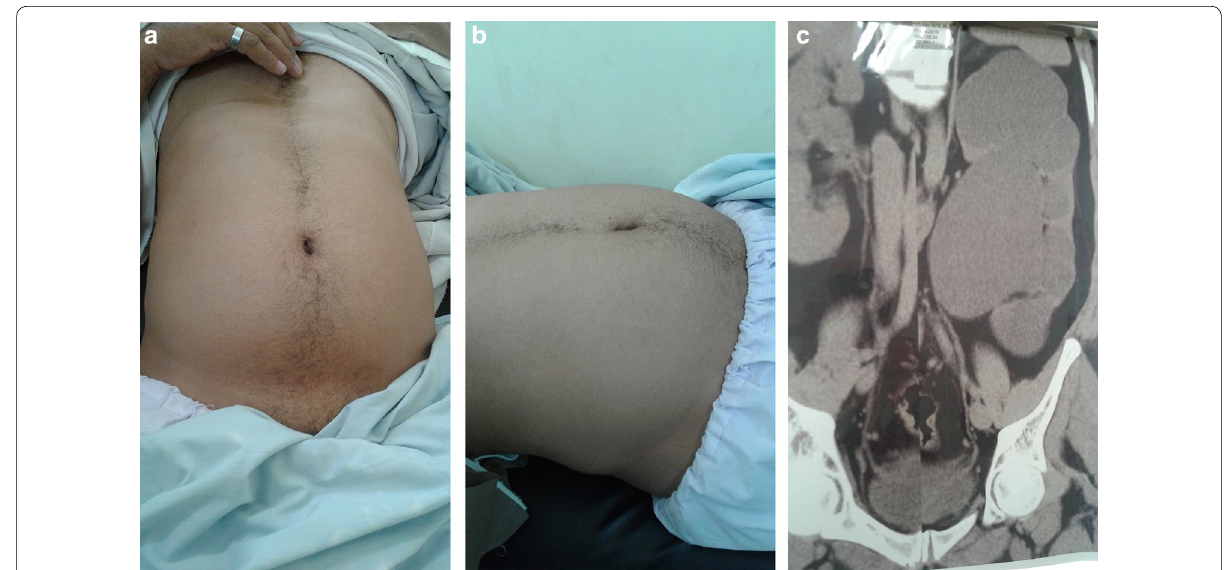
Fig. 2 A 45‑year‑old male patient presented with diffuse abdominal pain and distension due to left giant hydronephrosis. Clinically visible left hydronephrosis seen in caudo‑cephalic ( a ) and lateral ( b ) views. c Non‑contrast multi‑slice computed tomography film showing severe left hydronephrosis with lost parenchymal thickness due to pelvi‑ureteral junction obstruction and normal right kidney